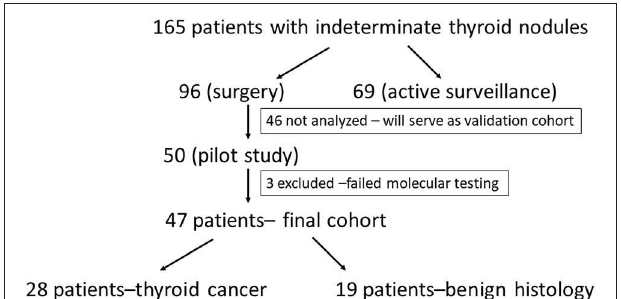
FIGURE 1 | Outline of the process leading to inclusion of the patients for this pilot